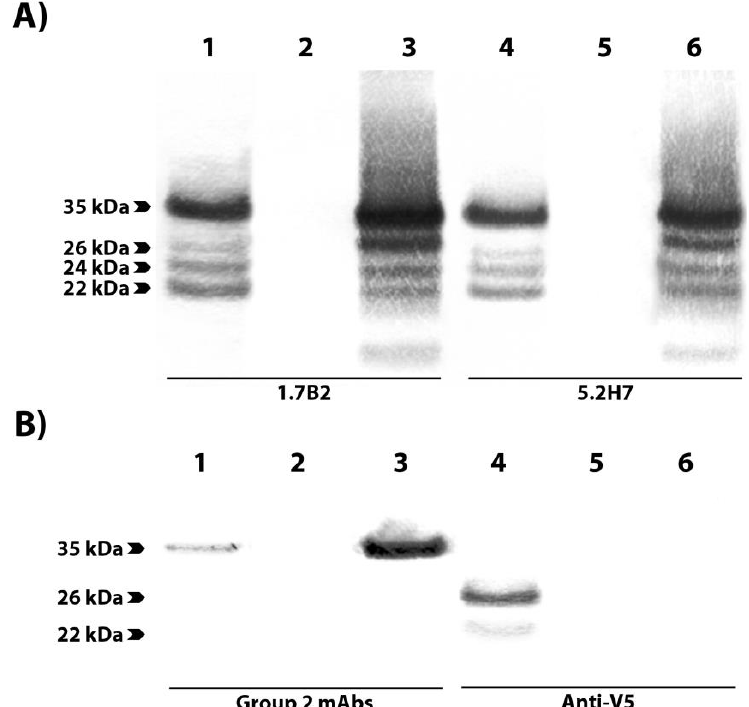
Figure 6. Reactivity of anti-CP mAbs with full length and truncated versions of native and recombinant CP. Reactivity of mAbs 1.7B2 (lanes A1–3), 5.2H7 (lanes A4–6), cocktail of group 2 mAbs (lanes B1–3) and anti-V5 mAb (lanes B4–6) in Western blot against boiled and reduced lysates of COS-7L cells expressing rCap (lanes 1 and 4), mock-transfected COS-7L cells (lanes 2 and 5), and CHIKV-infected C6/36 cells (lanes 3 and 6).